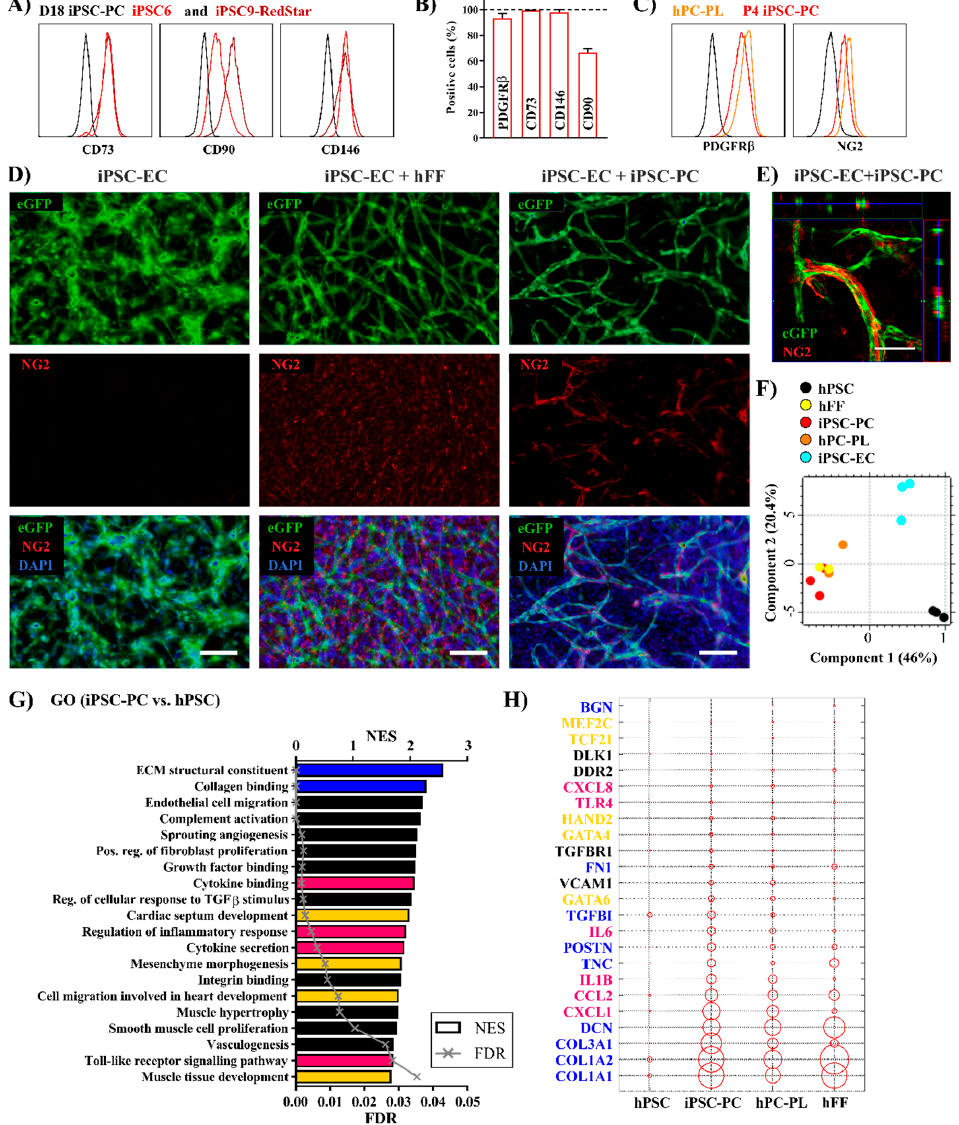
Figure 2. iPSC-PCs exhibit a PC-like function and cardiac phenotype. ( A ) Flow cytometric analysis of the mesenchymal surface marker expression post-maturation on D18 (black line—isotype control) and, ( B ) following expansion, in P4 ( n = 3). ( C ) The level of PDGFR β and NG2 in iPSC-PCs (P4) compared to hPC-PL (black line—isotype control). ( D ) Network formation in fibrin matrices (cultured in EGM-2 for 7 days) containing iPSC-EC only, iPSC-EC+hFF, and iPSC-EC+iPSC-PC, and NG2 expression in the fixed co-cultures. Nuclei stained with DAPI, iPSC-ECs express eGFP (iPSC9_eGFP). Scale bars: 100 µm. ( E ) Higher magnification Z-stack image of iPSC-EC+iPSC-PC networks with orthogonal projections. ( F ) PCA plot showing the first two principal components (data points represent one sample in the microarray analysis). ( G ) Significantly enriched gene ontologies (GOs) in iPSC-PC vs. hPSC (selected genes from the GOs marked with blue, pink, and yellow are shown on plot G). ( H ) Expression of ECM-related structural genes (blue), cardiac transcription factors (yellow), and immunomodulatory cytokines/receptors (pink) in hPSCs, primary PCs and Fbs, and iPSC-PCs. On the balloon plot, the size of the circles represents the average gene expression of sample groups relative to GAPDH (scaling factor: 300 ×